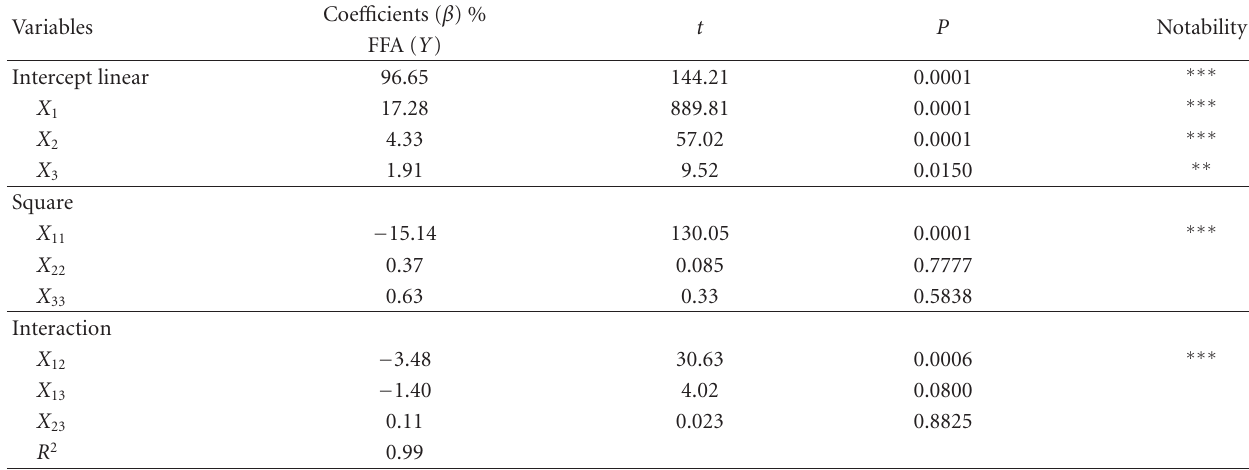
Table 3: Regression coe ffi cients of the predicted quadratic polynomial model for response variables Y (FFA%).